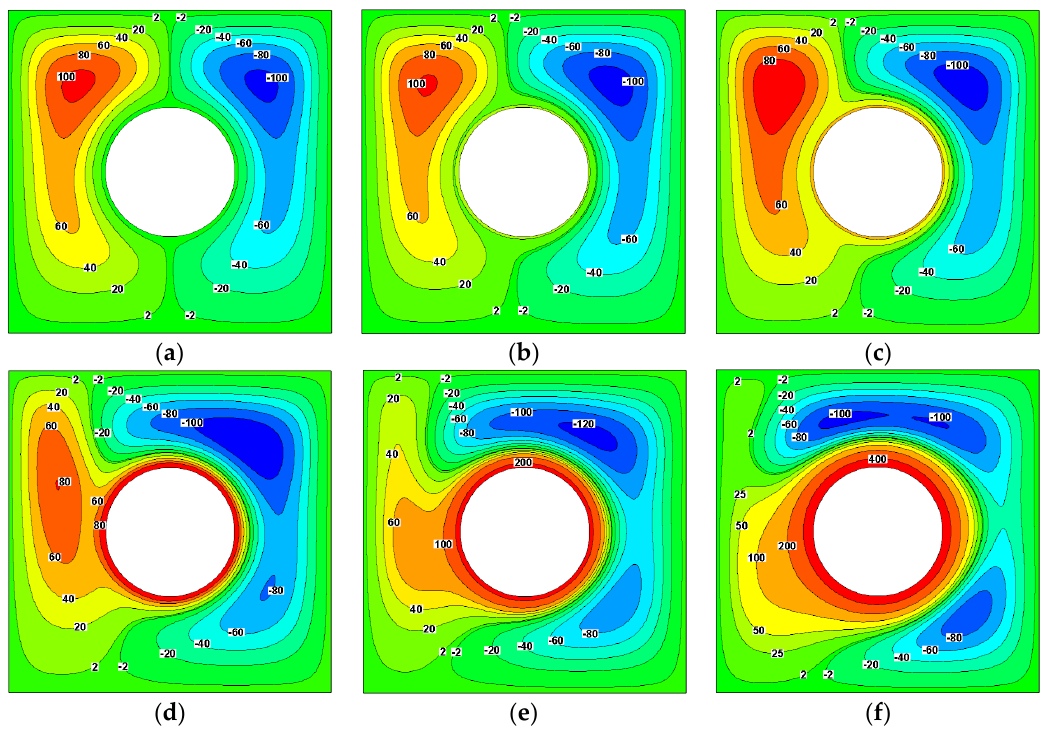
Figure 8. ( a ) N = 0, ( b ) N = 10, ( c ) N = 20, ( d ) N = 50, ( e ) N = 100, ( f ) N = 200. Contours of stream function at λ = 0.4, Ha = 40 and Ra = 10 6 .